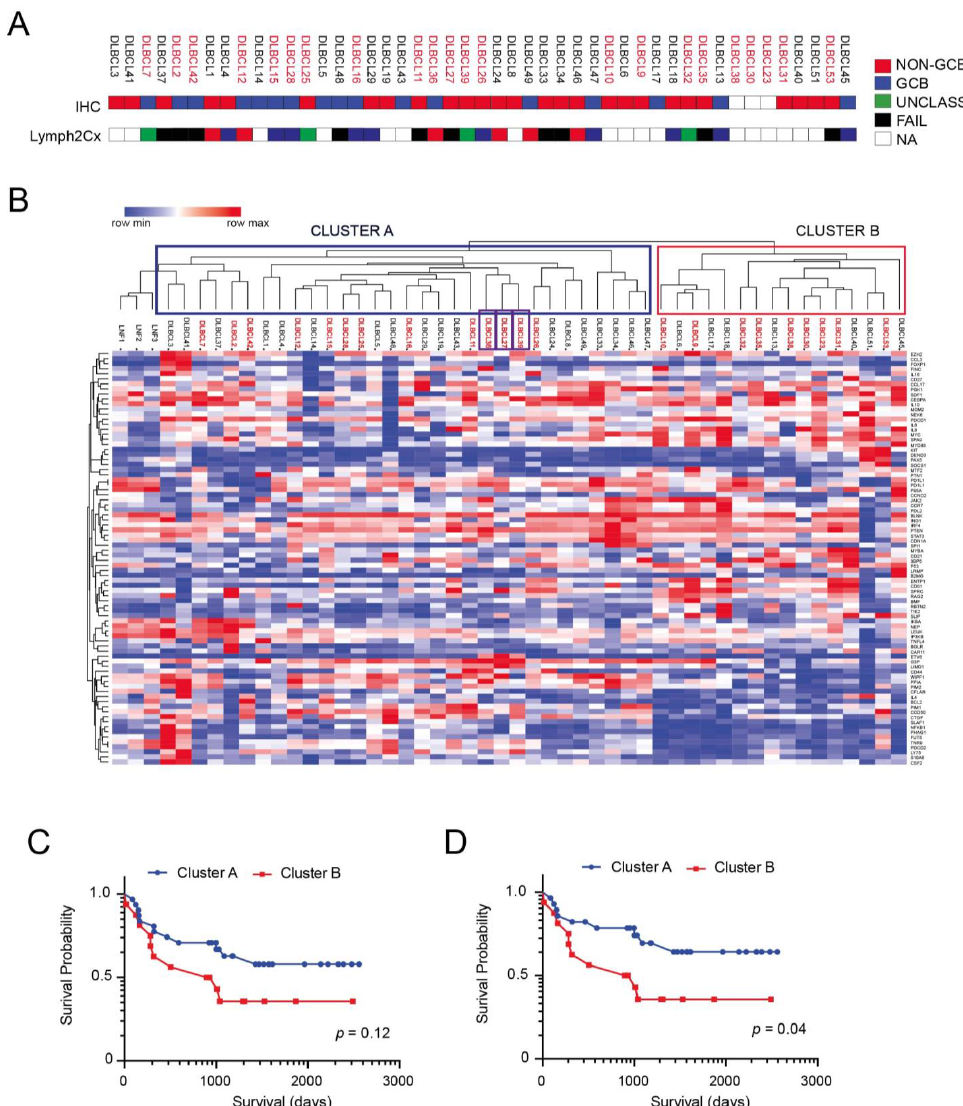
Figure 1. Performance of FFPA in stratifying DLBCL patient samples. ( A ) Cell-of-origin (COO) subtyping from the Hans IHC algorithm and Lymph2Cx assay for the cohort of patient samples ( n = 47). ( B ) Unsupervised hierarchical Clustering of DLBCL samples based on differentially abundant proteins. Samples labeled in red correspond to patients which had an adverse event (death). Primary DLBCL CNS cases are identified by purple boxes. ( C ) Kaplan–Meier curves of OS in the two clusters (Cluster A and B) identified by using FFPA analysis. ( D ) Kaplan–Meier curves of OS in the two clusters (Cluster A and B) identified by using FFPA analysis following the exclusion of primary DLBCL CNS